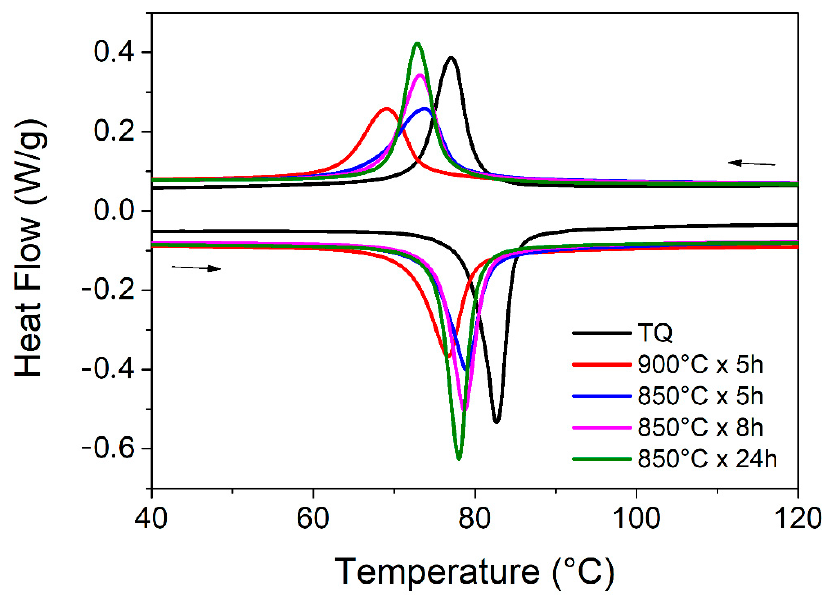
Figure 3. DSC analysis of NiTiCu20 samples.